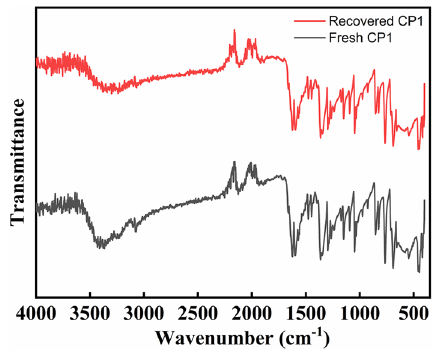
Figure 1. FTIR spectra of fresh and recovered CP1 .